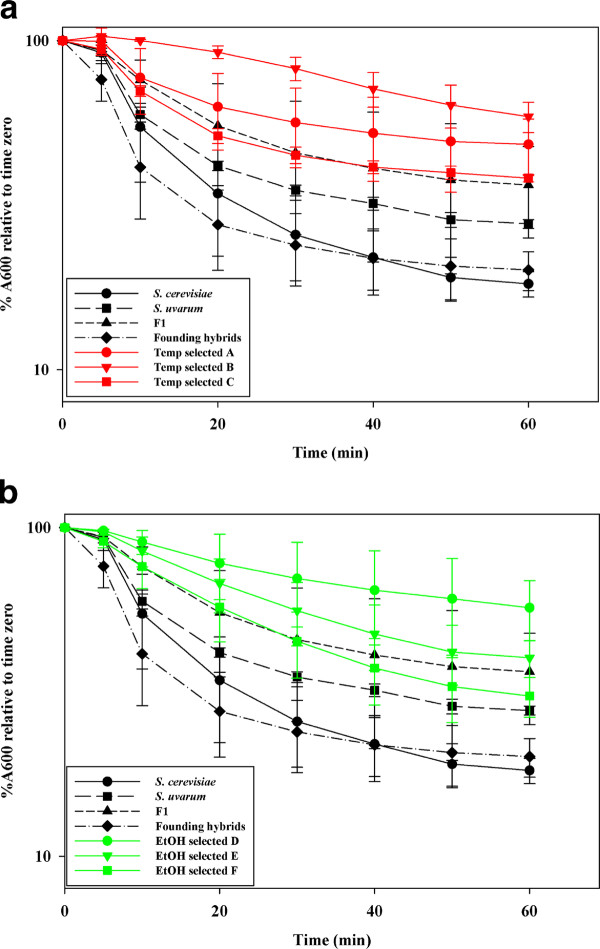
Resistance of parental, founding hybrid, and (A) temperature-selected or (B) ethanol-selected hybrid yeast to zymolyase. Cell wall dissolution was assayed by exposing yeast to zymolyase, placing them in spheroplast buffer at 37°C, then monitoring decrease in absorbance over time at λ = 600 nm, relative to T0. Each point is the mean (n = 3) of isolates from each selection vessel (1 from each vessel), 3 founding isolates, the F1, or parental isolates (Mean ± S.E.).